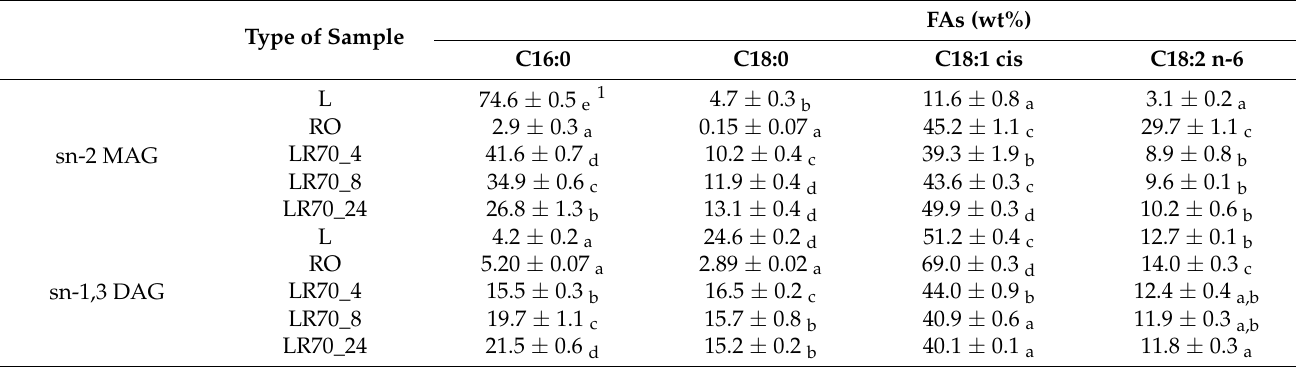
Table 2. FA composition in the internal and external positions of triacylglycerols (TAG) of raw materials and mixtures after interesterification.